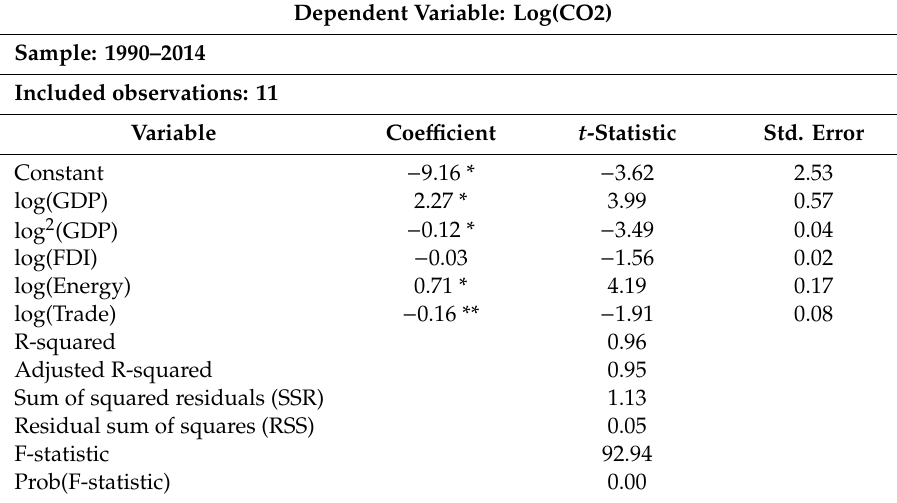
Table 1. Regression test results.